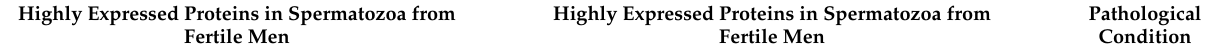
Highly Expressed Proteins in Spermatozoa from Fertile Men